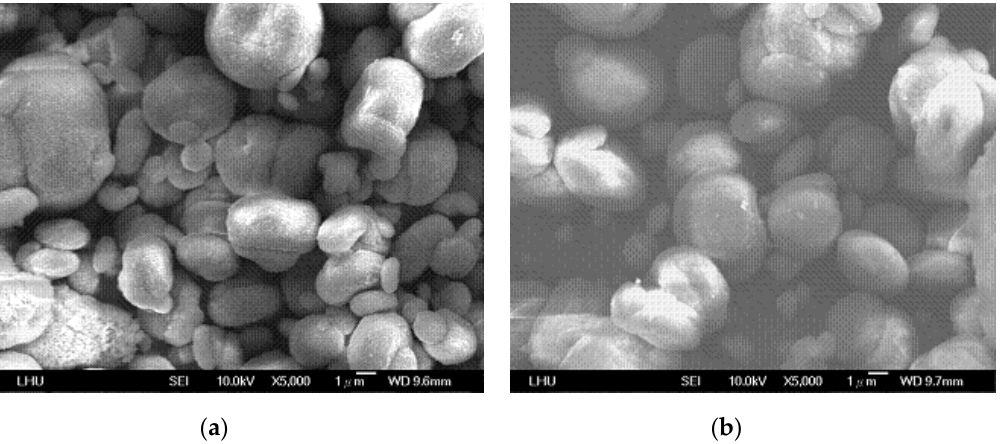
Figure 5. Effects of y 1 on the morphology and crystal size of vaterite (pH = 9, Q g = 4 L/min). ( a ) 20% (d p = 1.63 μ m) (No. 13); ( b ) 30% (d p = 1.65 μ m) (No. 16).